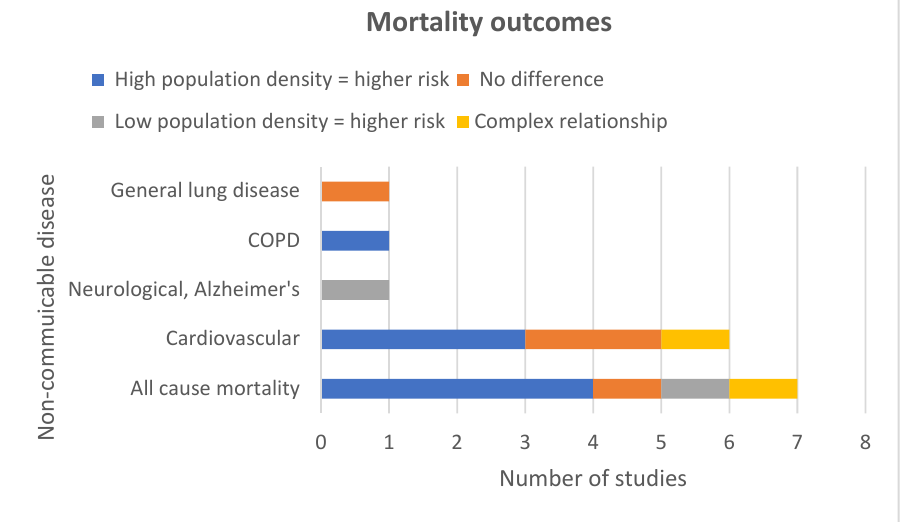
Figure 3. Mortality study outcomes.